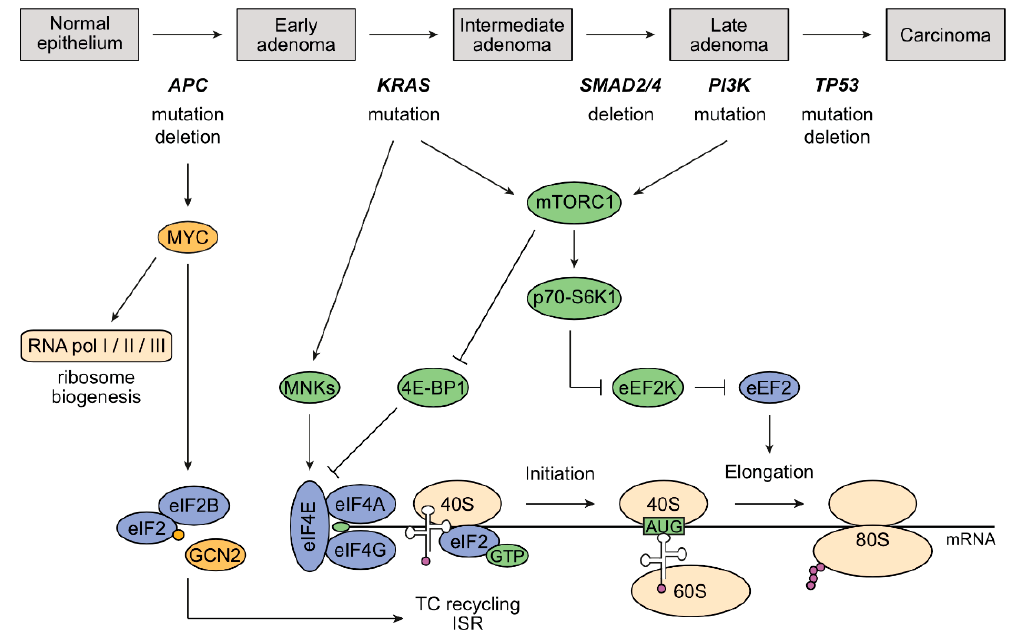
Figure 2. Genetic alterations in CRC in the adenoma-carcinoma sequence and their influence on mRNA translation. CRC develops over a series of clearly defined stages that are characterized by specific changes in oncogenes and tumor suppressor genes, that in turn regulate diverse mechanisms involved in mRNA translation. Black lines with arrow: activating signal; black lines with T bar: inhibitory signal; violet dots: amino acids generating a polypeptide chain, yellow dot: phosphorylation; green dot: 7-methylguanosine cap of mRNA; TC: ternary complex; ISR: integrated stress response; RNA pol I-III: RNA polymerase I–III.